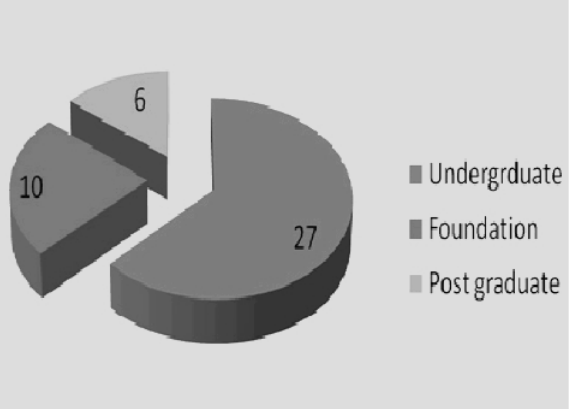
Figure 1: Academic level of HEIs courses